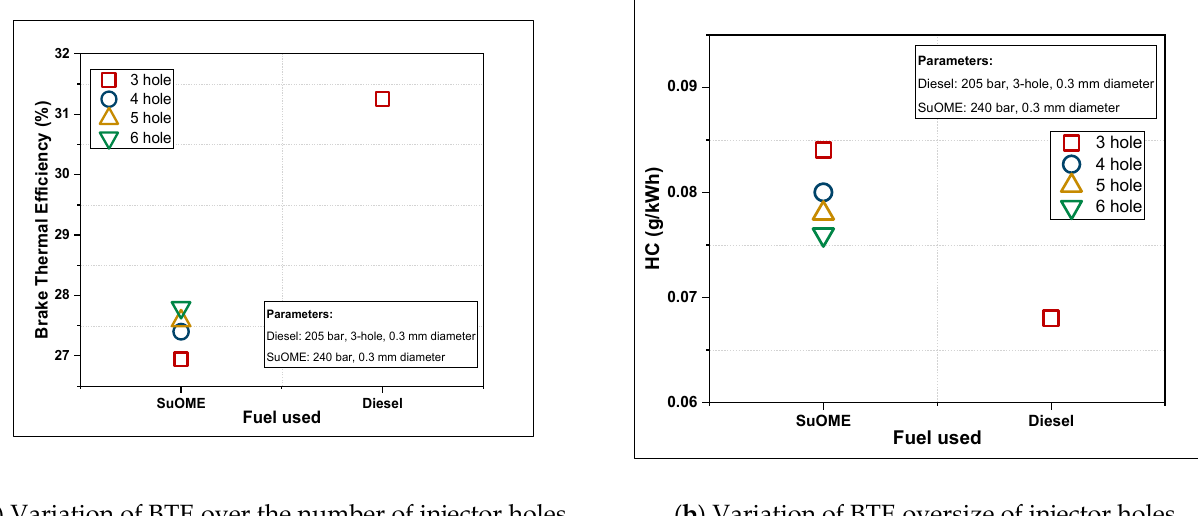
Figure 5. Variations of BTE upon ( a ) number of injector holes and ( b ) orifice diameter of the injector.